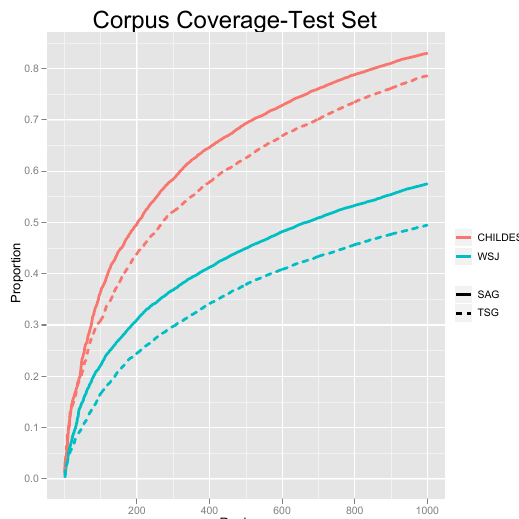
Figure 10: Cumulative coverage (generalization)